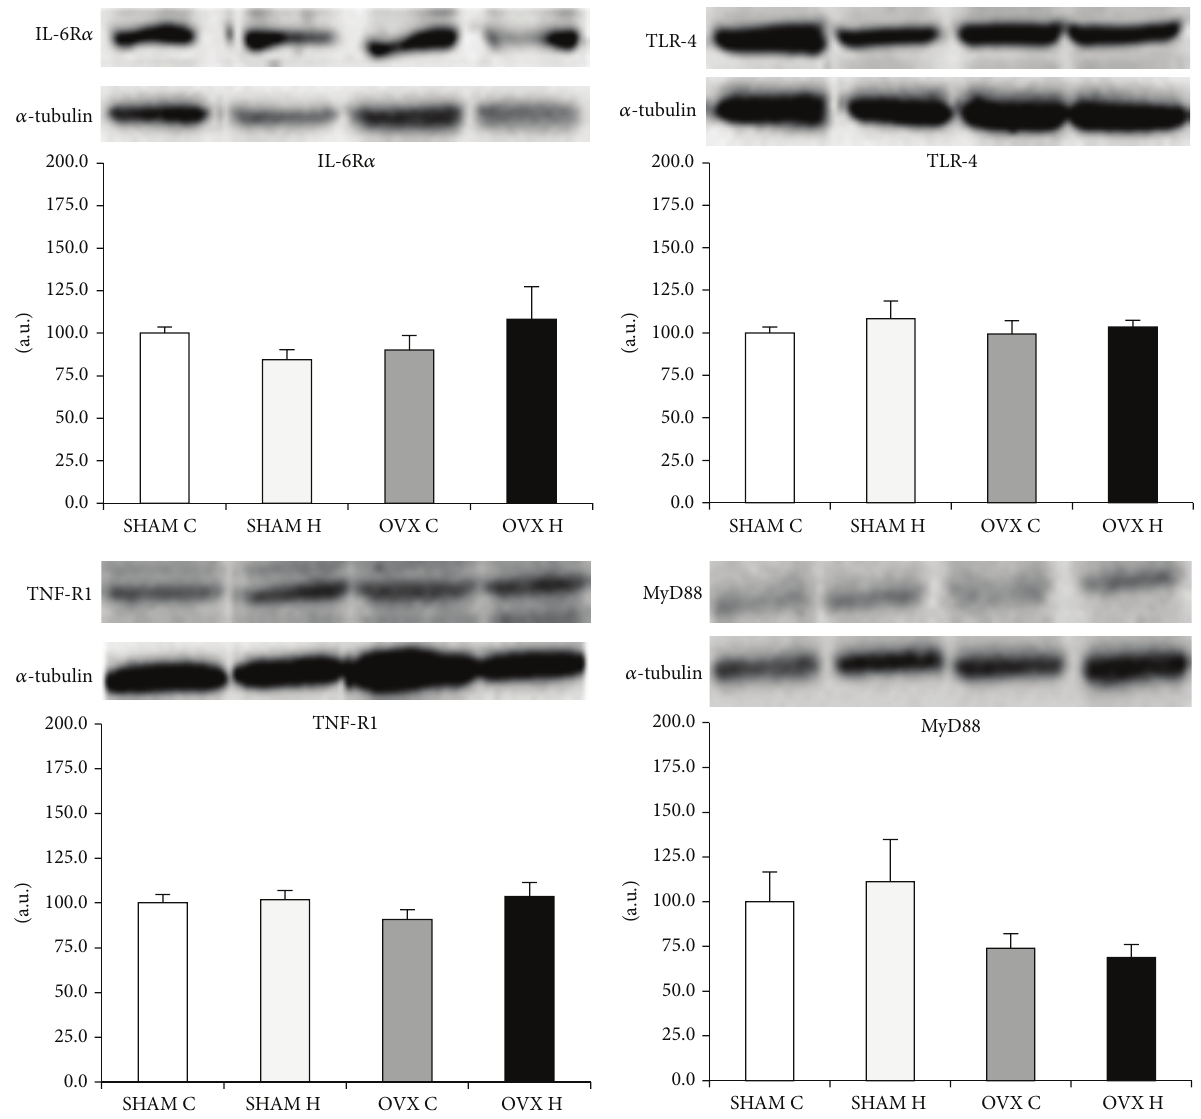
Figure 6: Liver IL-6R 𝛼 , TNF-R1, TLR-4, and MyD88 protein content: (SHAM C) sham group treated with control diet; (SHAM H) sham group treated with hyperlipidic diet; (OVX C) ovariectomized group treated with control diet; (OVX H) ovariectomized group treated with hyperlipidic diet. The numbers of samples varied between four and